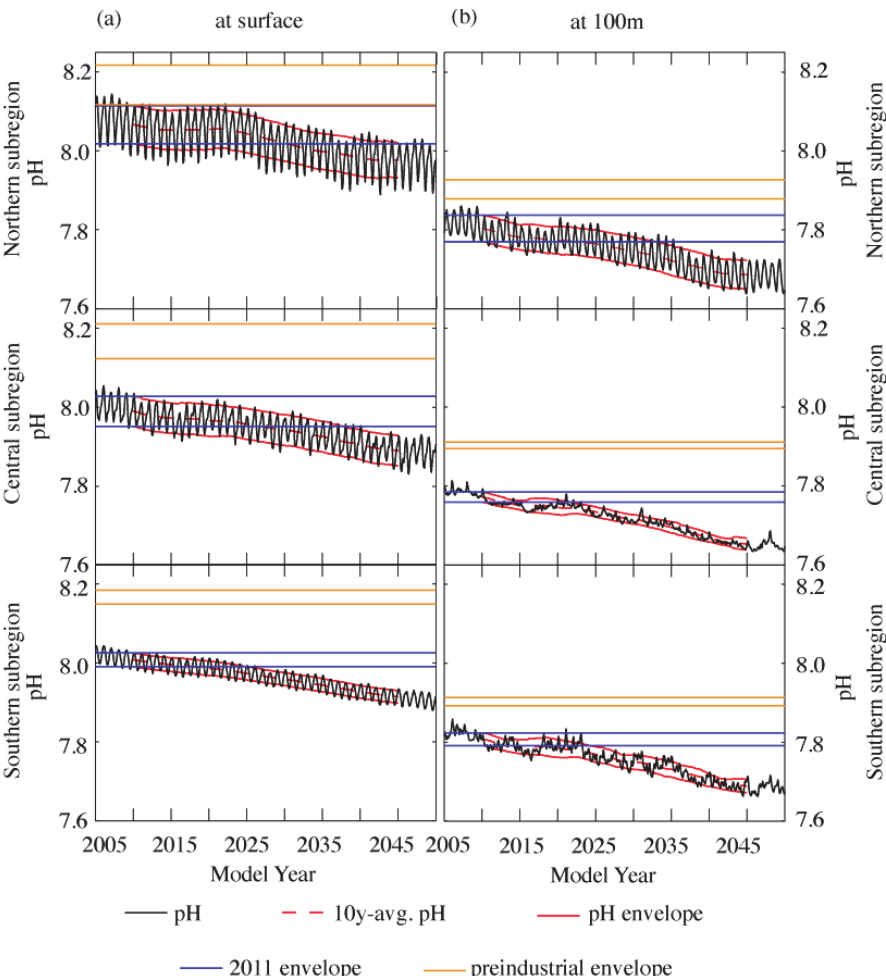
Fig. 11. Simulated time series of monthly mean pH (black) at (a) the surface and (b) 100m depth, for the northern (top panel), central (center panel) and southern (bottom panel) subregions, with the 10-yr running average (red dashed line) for all grid cells of each subregion. The area between the solid lines defines the range of annual variability or envelope (mean ± (1STD × var cf )) of pH for the preindustrial (orange, ∼ 270ppm atmospheric p CO 2 ), 2011 (black, ∼ 395 ppm atmospheric p CO ) and transient (red) simulations. The envelopes are adjusted with the correction factor var (Sect. 2.4).